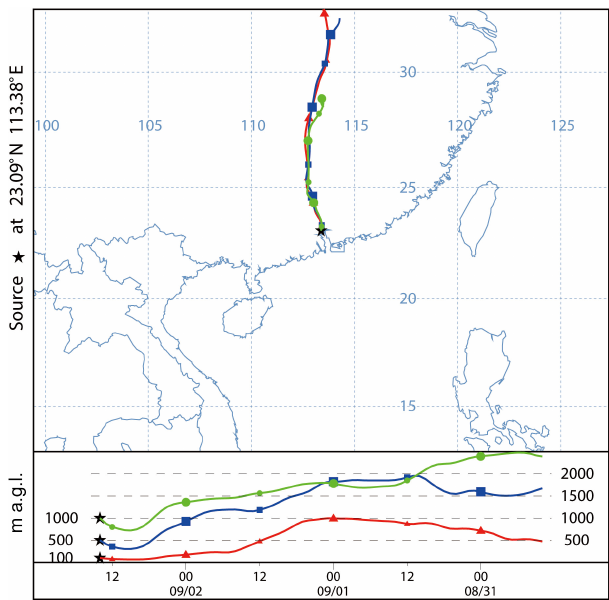
Figure 7. Backward trajectories at 100, 500, and 1000m, ending at 22:00LT on 2 September 2020, determined by the HYSPLIT